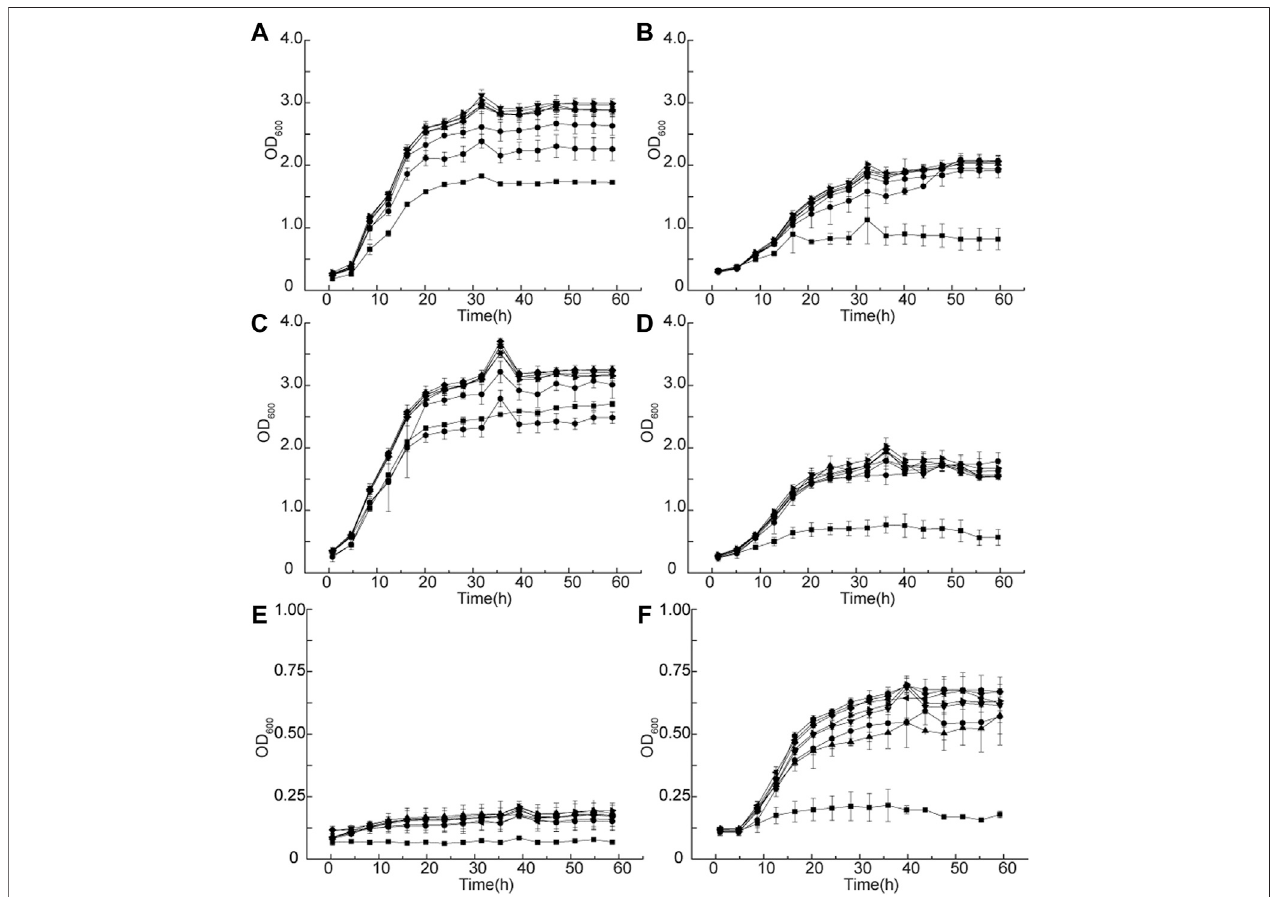
FIGURE 6 | Growth curve of G. oxydans at different temperatures. Growth curves at (A) 50 g/L of D-sorbitol, 30 ° C; (B) 300 g/L of D-sorbitol, 30 ° C; (C) 50 g/L of D-sorbitol, 35 ° C; (D) 300 g/L of D-sorbitol, 35 ° C; (E) 50 g/L of D-sorbitol, 40 ° C; and (F) 300 g/L of D-sorbitol, 40 ° C. Square: G. oxydans WSH-004; circle: G. oxydans MMC4; up-triangle: G. oxydans MMC5; down-triangle: G. oxydans MMC6; rhombus: G. oxydans MMC7; left triangle: G. oxydans MMC8; right triangle: G. oxydans MMC9; and pentagon: G. oxydans